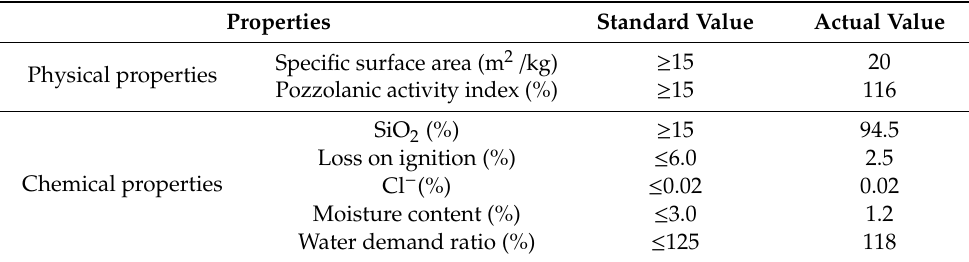
Table 2. Physical and chemical properties of silica fume.